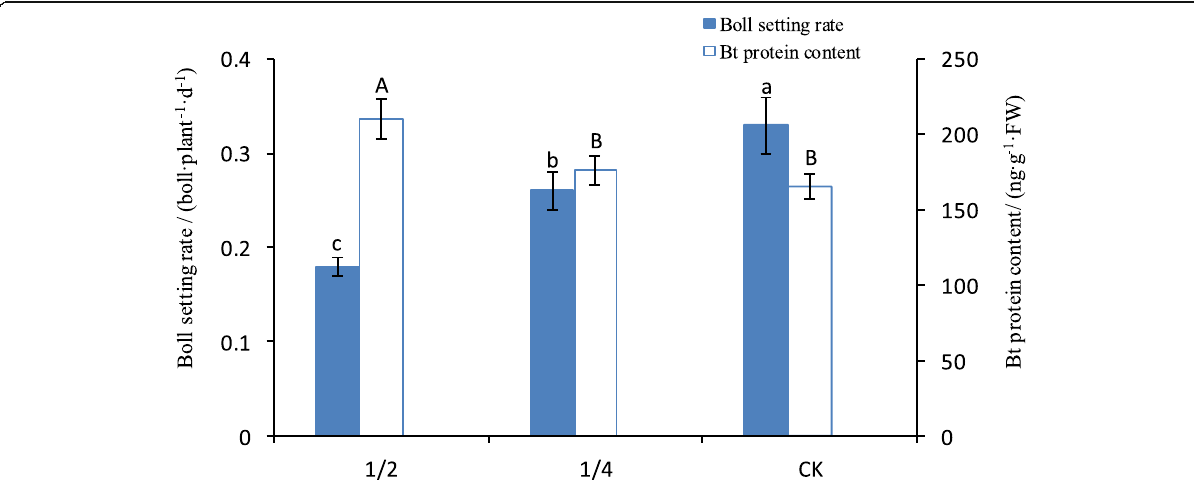
Fig. 7 The boll setting rate per plant and boll wall Bt toxin content under different flower-removal treatments in 2018. Sympol 1/4 and 1/2 represented one-fourth and half of the white flowers was removed during peak flowering stage respectively, CK was the control. The vertical bar represents S.E. of the mean ( n = 3) when the value exceeds the size of the symbol. Lowercase letters indicate significance analysis among boll setting rate per plant, and capital letters indicate significance analysis among Bt protein content. The same letter among treatments is not significantly different ( P ≥ 0.05)